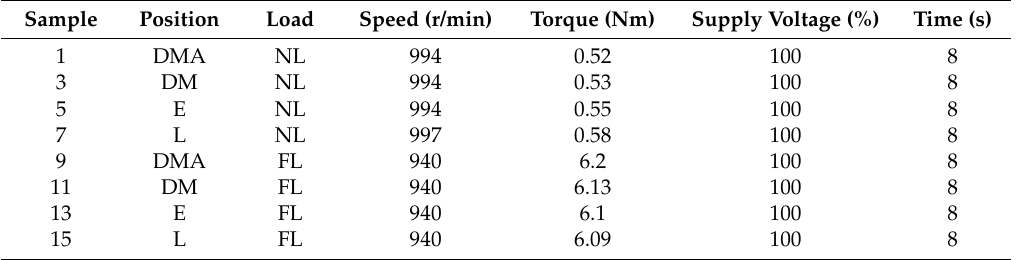
Table 4. Characteristics of the experiment for the damaged motor with a broken bar at steady